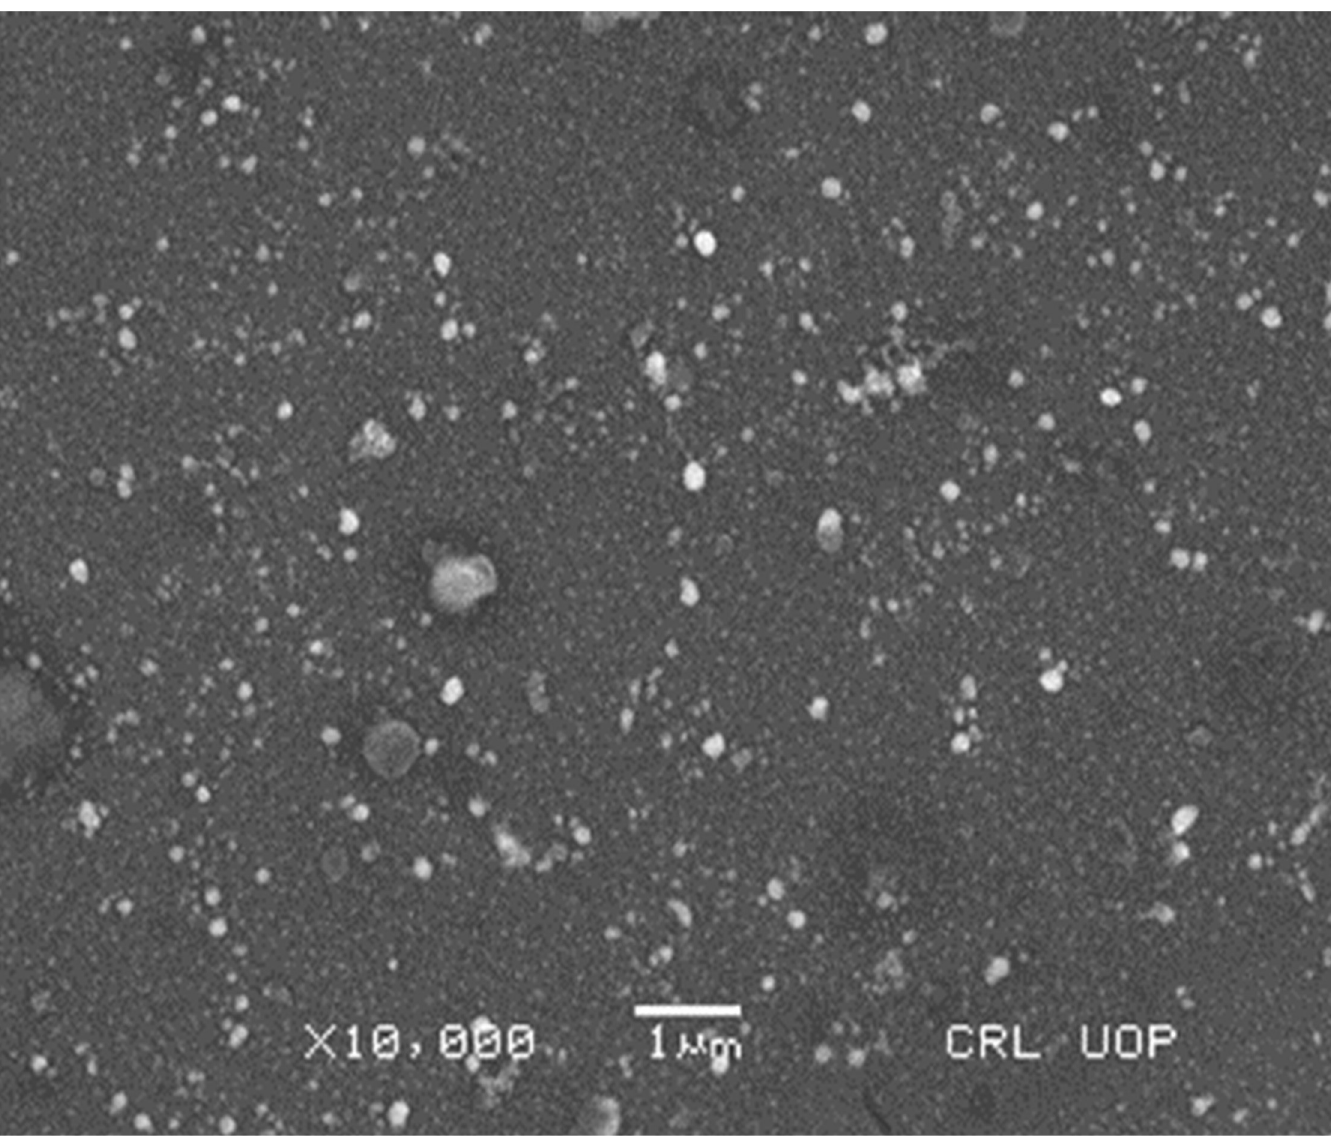
PLOS ONE | https://doi.org/10.1371/journal.pone.0281675 March 8,